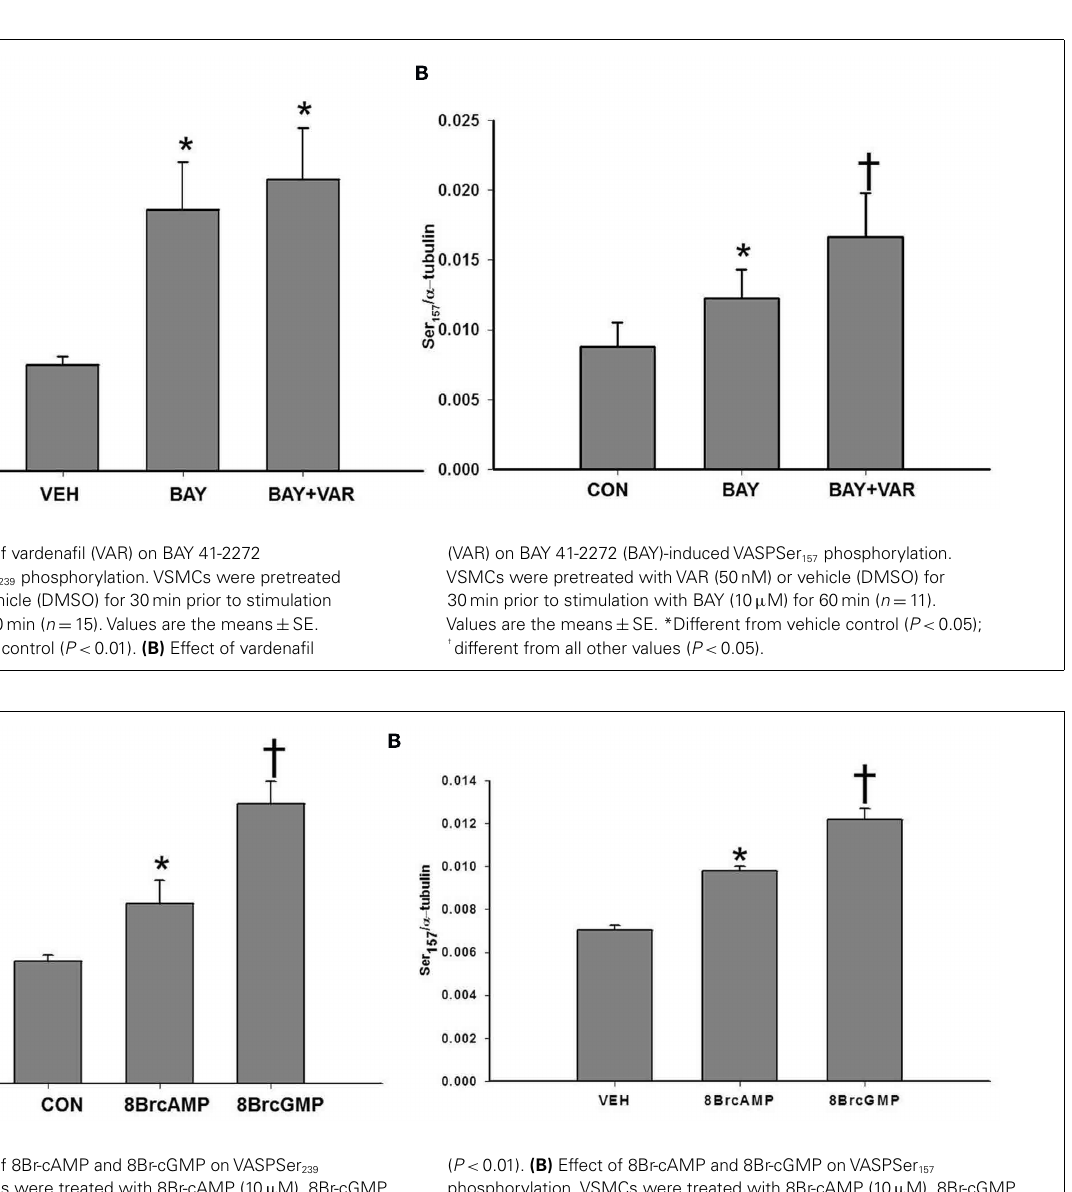
( P < 0.01). (B) Effect of 8Br-cAMP and 8Br-cGMP onVASPSer 157 phosphorylation.VSMCs were treated with 8Br-cAMP (10 μ M), 8Br-cGMP (10 μ M), or vehicle for 30min ( n = 3).Values are the means ± SE. *Different from vehicle control ( P < 0.05); † different from all other values ( P <